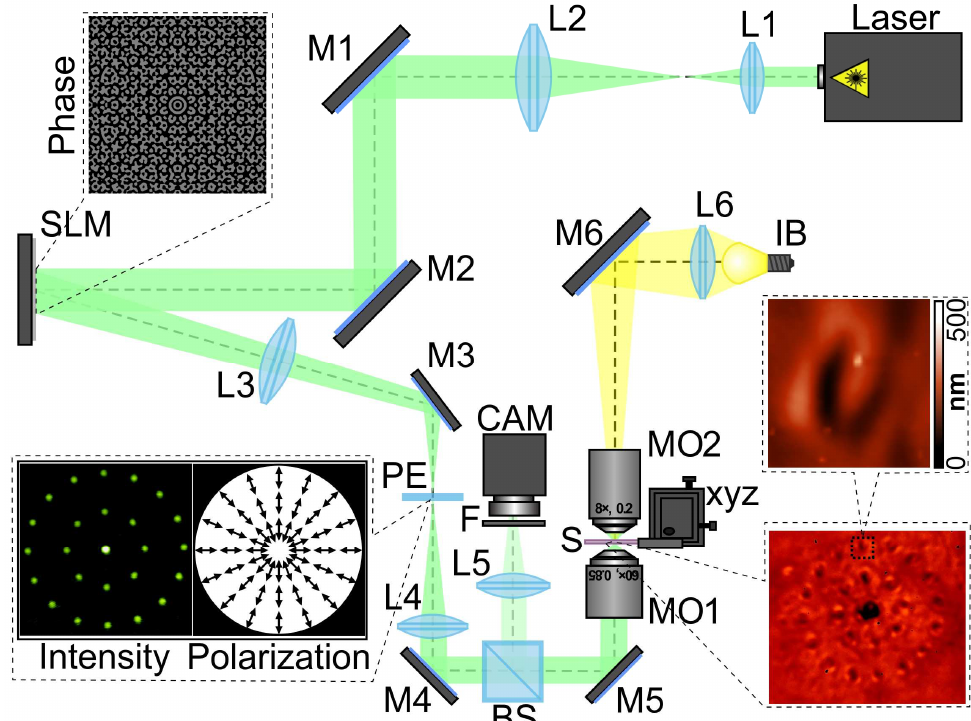
Figure 2. The experimental setup for polarization-sensitive laser patterning of thin azopolymer films. The laser is a solid-state laser (λ=532 nm); L1, L2, L3, L4, L5, and L6 are spherical lenses ( f 1 = 350 mm, f 2 = 300 mm, f 3 = 500 mm, f 4 = 400 mm, f 5 = 50 mm, and f 6 = 150 mm); M1, M2, M3, M4, M5, and M6 are mirrors; SLM is a reflective spatial light modulator (HOLOEYE PLUTO VIS); PE is a polarizing element; BS is a beam splitter; MO1 and MO2 are micro-objectives (NA = 0.4 and 0.1); S is a glass substrate with a carbazole-containing azopolymer thin film that was mounted on the 3-axis XYZ translation stage; IB is a light bulb; F is a neutral density filter; and CAM is a ToupCam UCMOS08000KPB video camera. The insets show a phase transmission function of the designed diffractive beam splitter for generation of a set of 24 light spots located on two circles with different radii; intensity and polarization patterns in the Fourier plane of the used 4- f optical system; and optical microscopy image of the patterned azopolymer films with an enlarged image of a single fabricated structure obtained using atomic force microscopy.